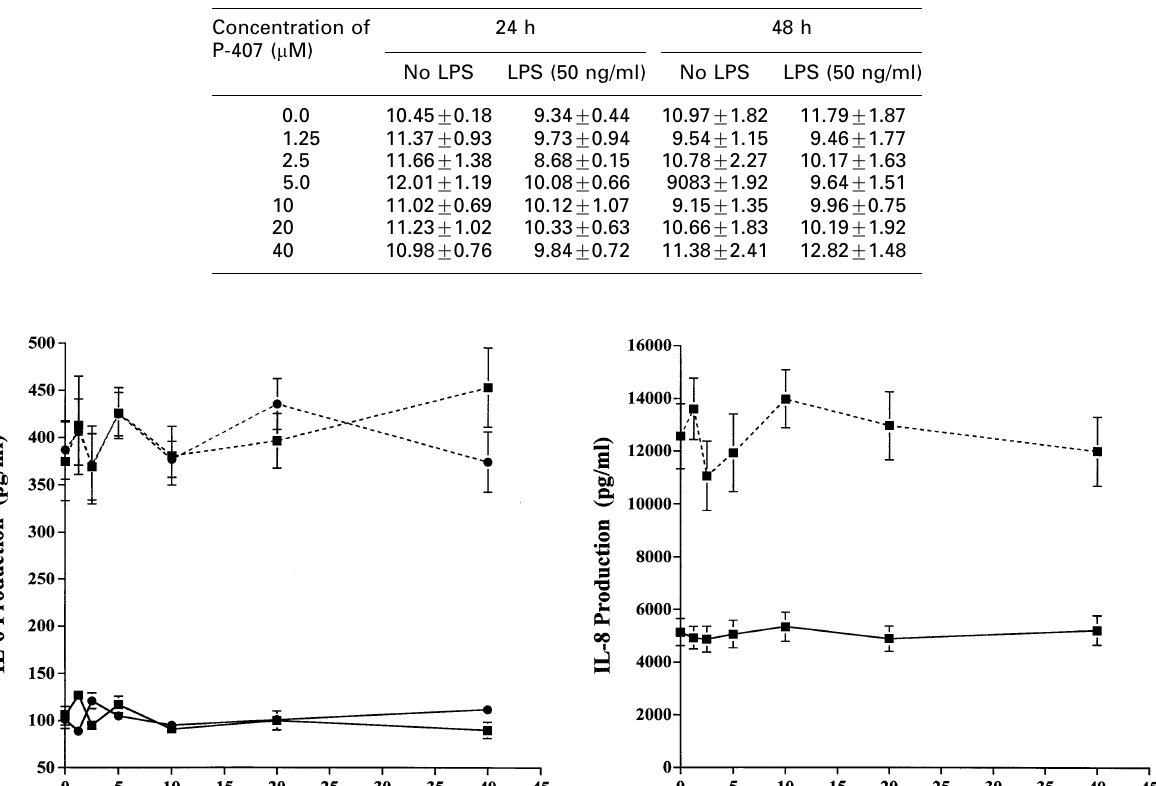
Table 1. Effect of P-407 on proliferation of HUVEC at 24 and 48 h Concentration of P-407 ( m M)